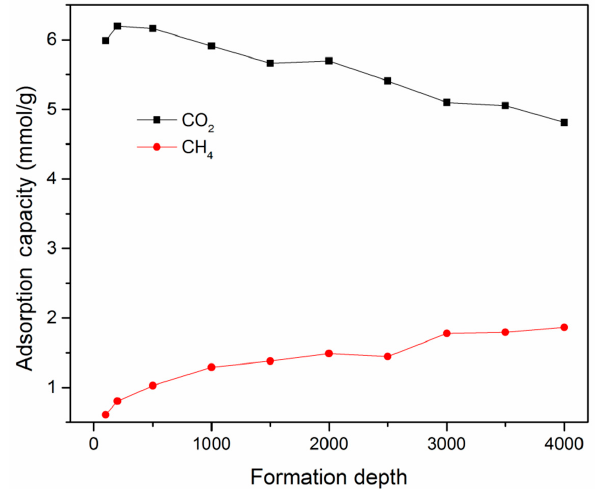
Figure 10. Variation of adsorption capacities of a CO 2 / CH 4 binary mixture as a function of buried depth of shale formation (mole fraction of CH 4 =